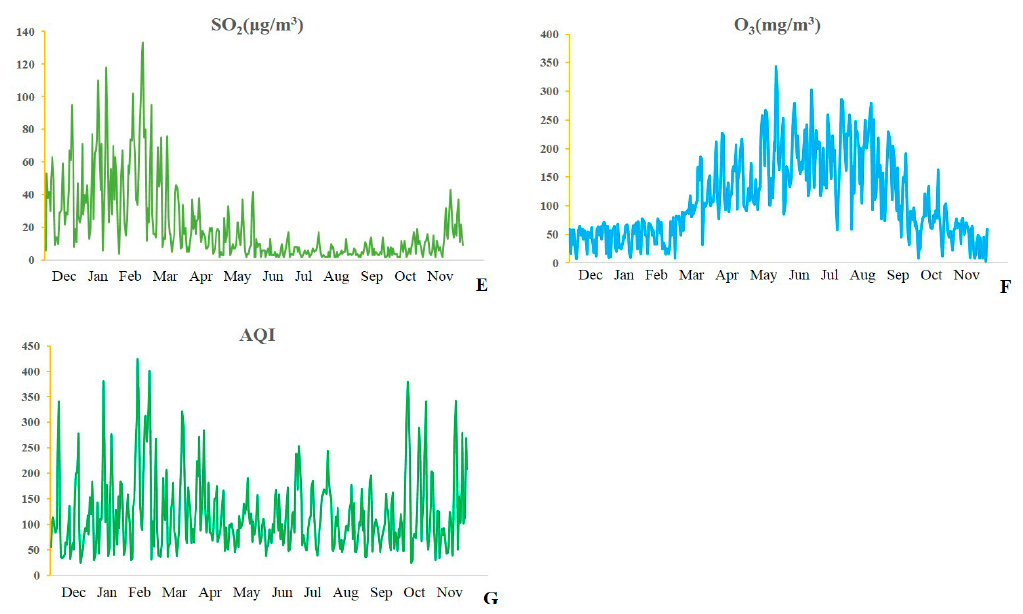
Figure 1. Variation of different air pollutants throughout the study year in panels A–F. ( A ) Variation of PM 2.5 in the study year; ( B ) Variation of PM 10 in the study year; ( C ) Variation of CO in the study year; ( D ) Variation of NO 2 in the study year; ( E ) Variation of SO 2 in the study year; ( F ) Variation of O 3 in the study year; ( G ) Variation of AQI in the study year. Maximal concentrations of air pollutants occurred during cold periods, except for O 3 , which showed an inverse trend. Panel G shows the variation of the Chinese AQI, which is a composite measure of air pollutants. Table 2. Correlation coefficients among air